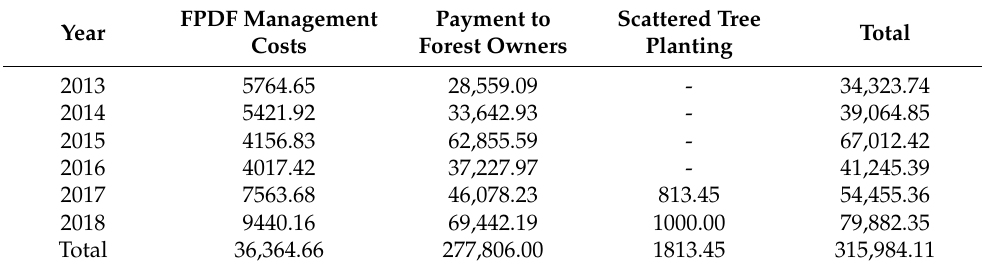
Table 4. PFES revenue spending (VND × million).